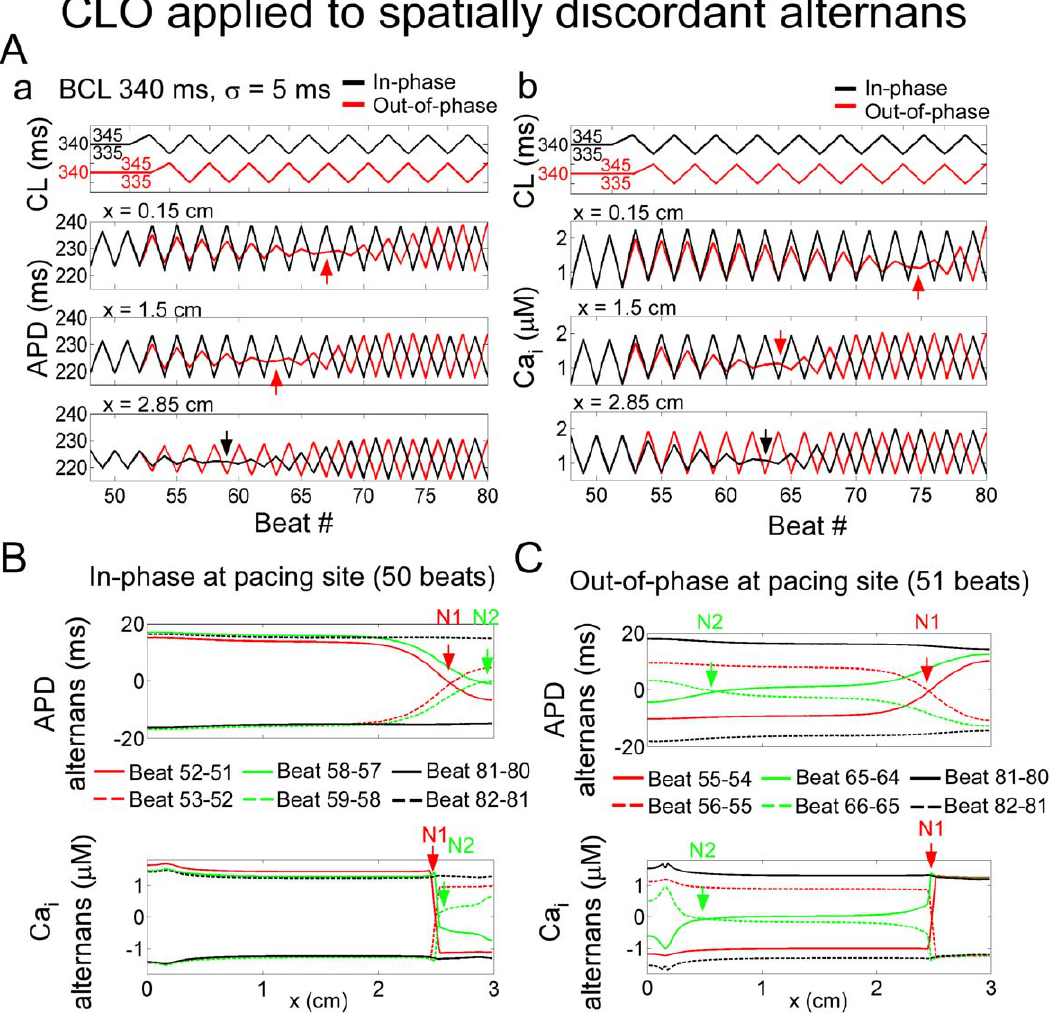
Figure 3. Cycle length oscillation applied during spatially discordant alternans in a one-dimensional cable ionic model. Simulation results are for the condition in which constant pacing at 340 ms induced spatially concordant alternans. See Figure 2 legend for description of the panels. Phase reversals are indicated by a black or red arrow.